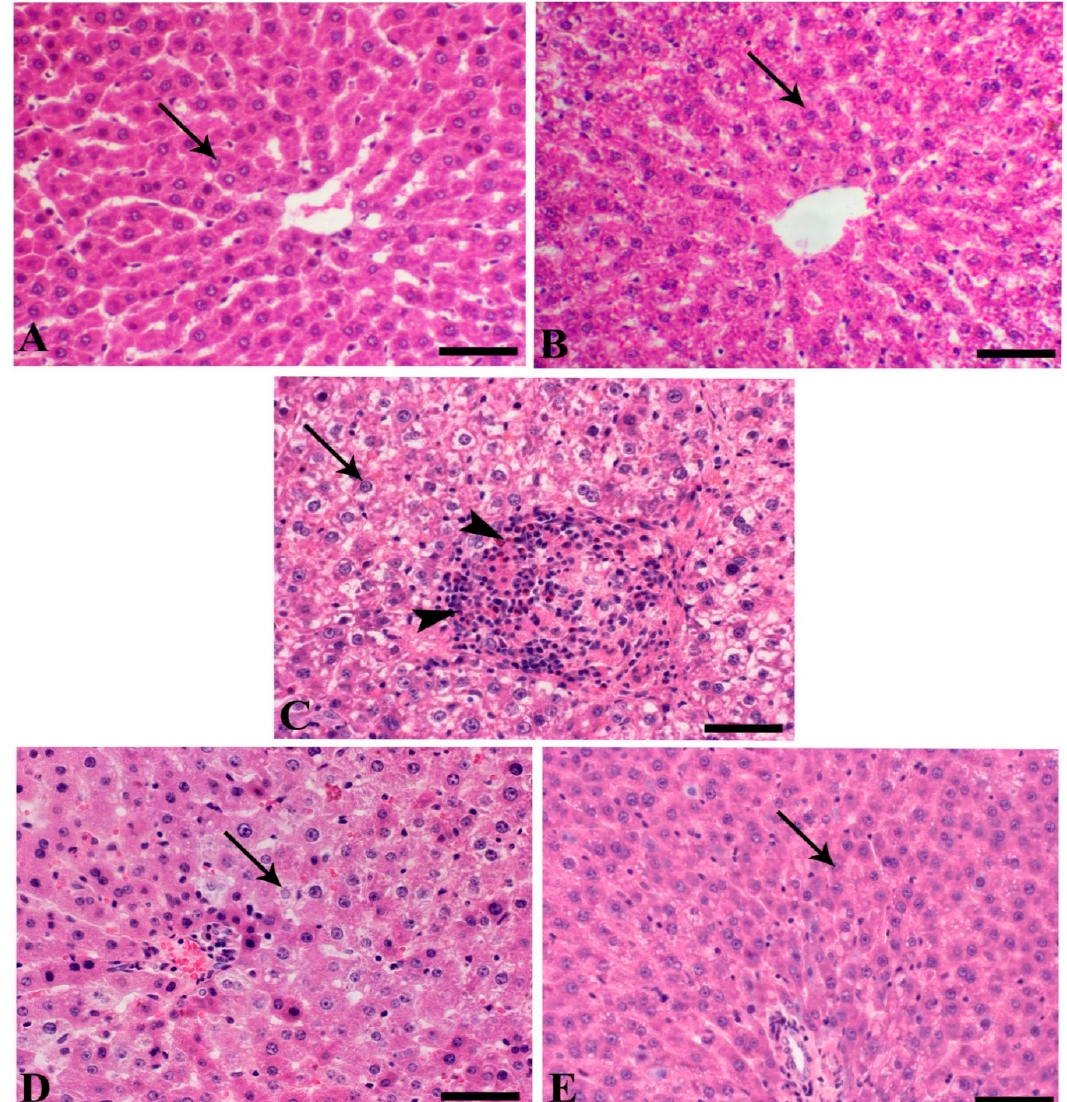
Figure 4. Liver of different animal groups. ( A ) Control, ( B ) sham SMC50 (arrows indicate normal hepatocytes), ( C ) C + ve (arrowheads indicate granuloma-like lesion rich in a high number of lymphocytes, macrophages, and eosinophils), ( D ) C + SMC25 (arrow reveals a decrease in hepatic vacuolation), and ( E ) C + SMC50 (arrow indicates mild hepatic vacuolation). H&E stain, bar = 50 μ m.